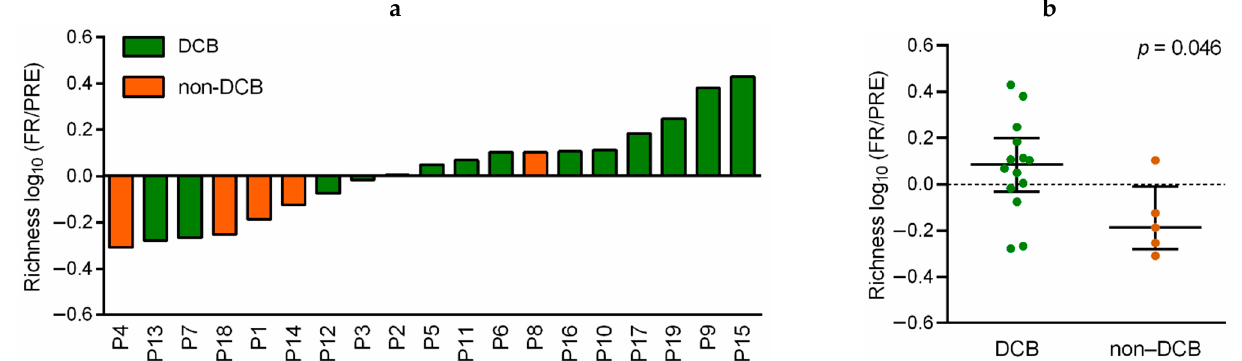
Figure 3. Correlation of dynamic richness of TCR- β repertoire in peripheral blood with response in anti-PD-1 treated NSCLC patients. ( a ) Richness log 10 (FR/PRE) between pretreatment (PRE) and first response assessment (FR) in patients with durable clinical benefit (DCB; in green) and non-durable clinical benefit (non-DCB; in orange). Each column represents a patient. ( b ) Comparison of richness log 10 (FR/PRE) between patients with DCB and non-DCB. P -value was obtained using the Mann–Whitney test. Error bars represent the interquartile range with a line at the median. Each dot represents a patient.